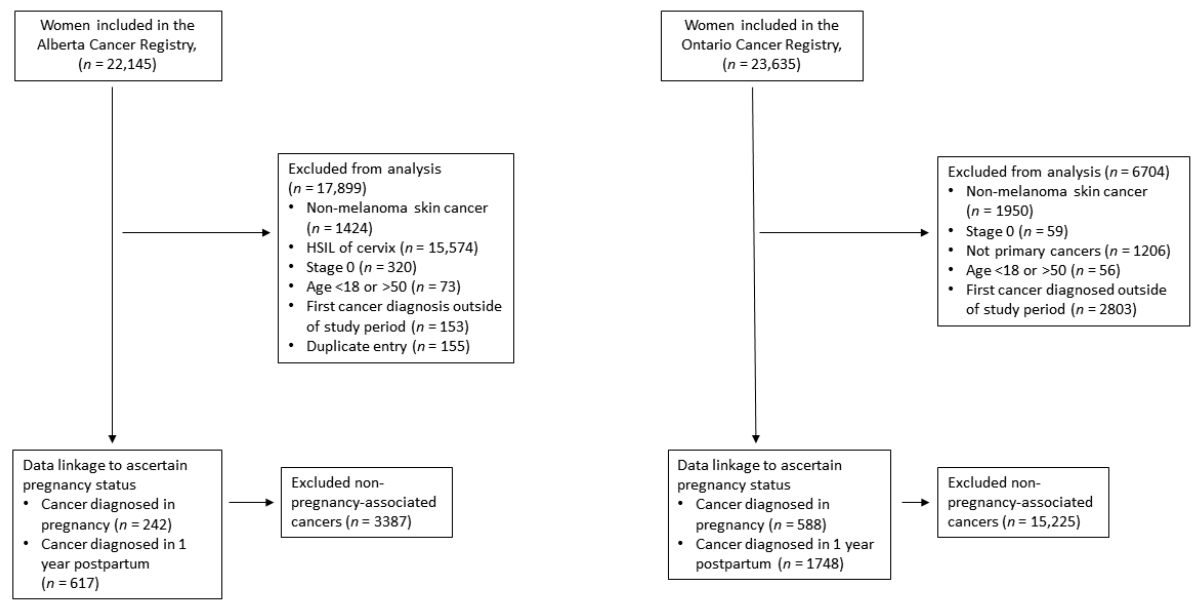
Figure 1. Study flow diagram.